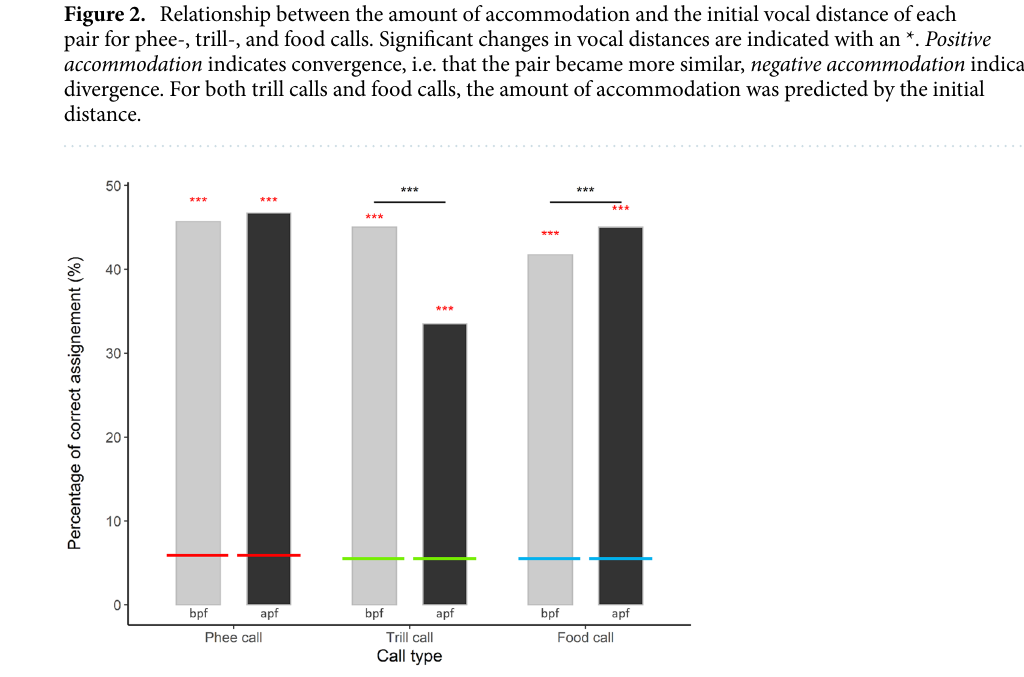
Figure 3. Statistical individual recognisability before and after pair formation. Percentage of correct assignments was obtained from a discriminant function analysis. Light grey bars indicate values of correct assignment before pair formation, dark grey bars after. Calls can be attributed to the correct individual by discriminant function analysis significantly better than expected by chance (red, green or blue line respectively, indicated by red asterisk) in all conditions. The amount of correct assignment though significantly decreased in trill calls after pair formation and increased in food calls (GLMM, indicated by black asterisk). We did not observe a significant change in the level of correct assignment in phee